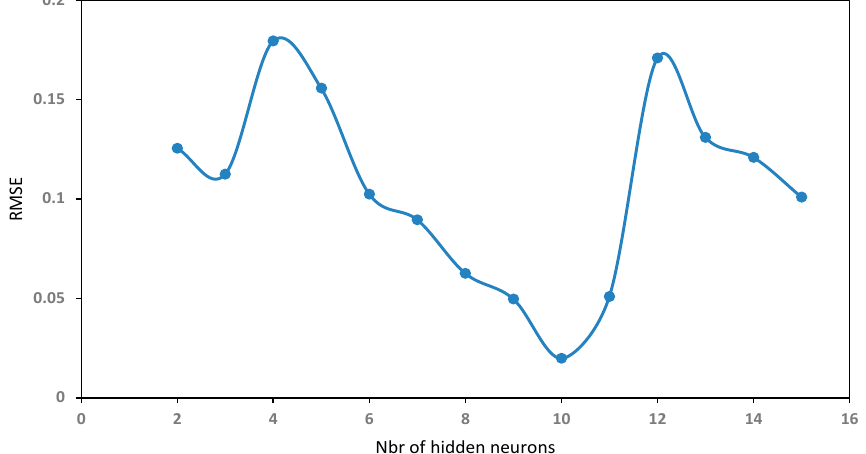
Figure 5. Effect of the number of hidden neurons on the RMSE.